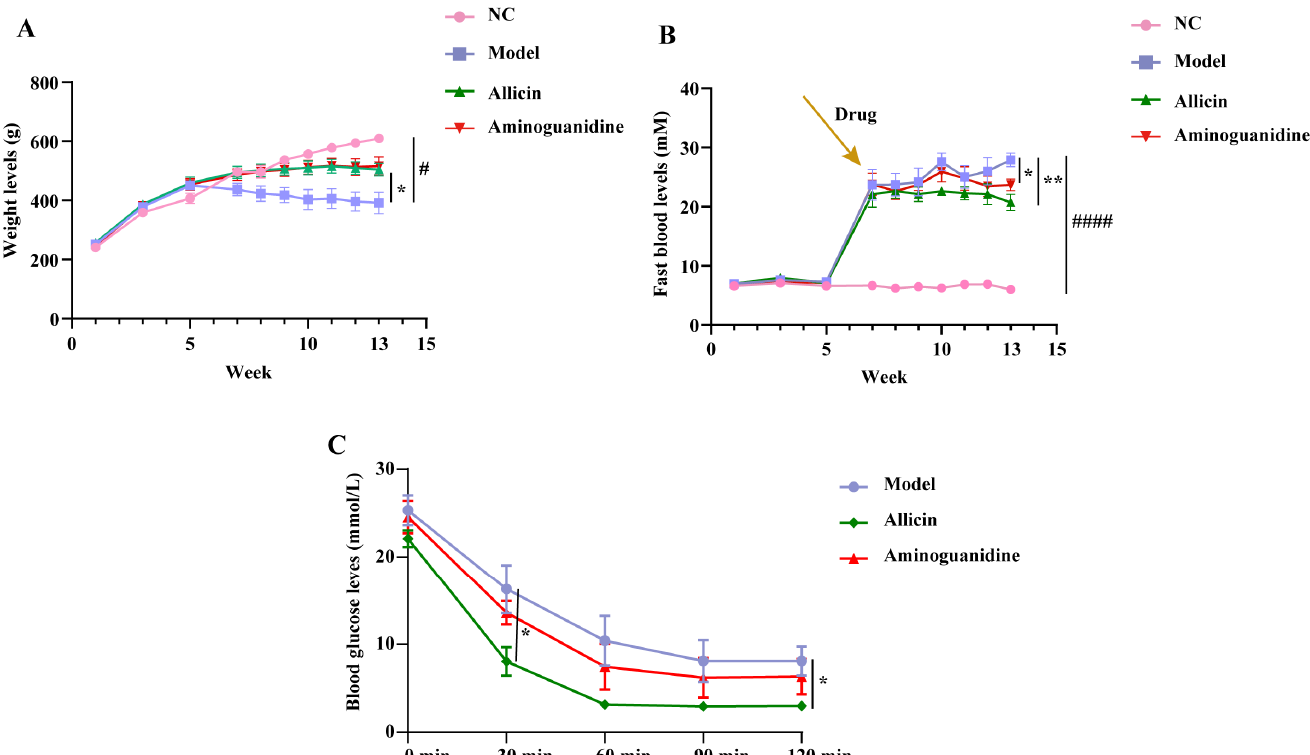
Figure 1. Effect of allicin on the weight and fasting blood glucose (FBG) levels of diabetic rats over the experimental cycle of thirteen weeks. The first week was adaptation feeding, the second week to the fifth week was high-fat induction, and the seventh week was the first week of the drug intervention, which continued for six weeks. The drugs were administered at the end of the 7th week of the experi- ment, with a 6-week dosing cycle. The experiment ended at the 13th week, and the rats were sacrificed at the same time. ( A ) Change in weight levels during allicin treatment for 6 weeks. ( B ) Change in FBG levels during allicin treatment for 6 weeks. ( C ) At the 12th week, the effects of allicin on the alleviation of insulin resistance in rats after modeling. This assay used aminoguanidine as a positive control. “#” Significant difference between the model group and NC group. “*” Significant difference between the model group and drug group ( #### p < 0.0001, # p < 0.05, ** p < 0.01, and * p < 0.05).